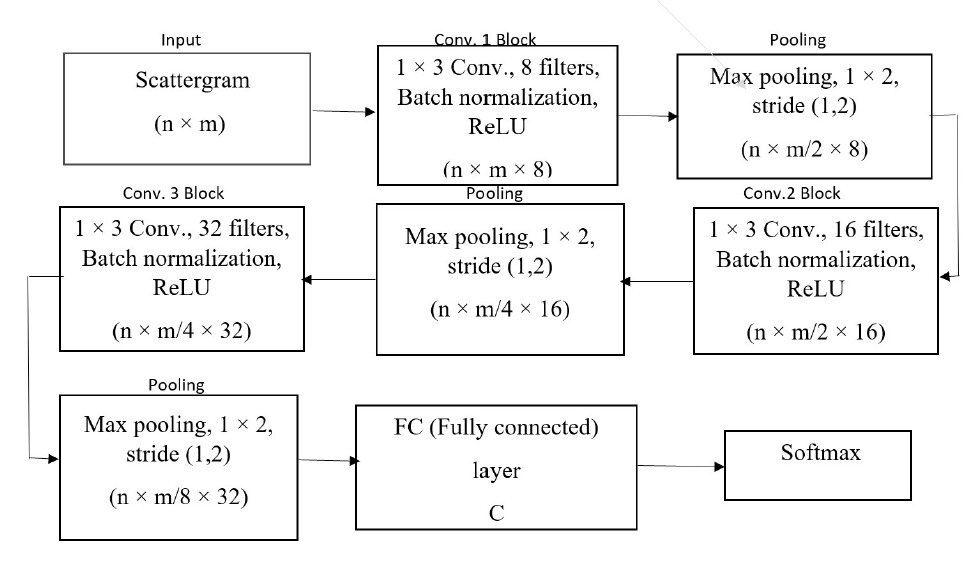
Figure 5. The CNN architecture